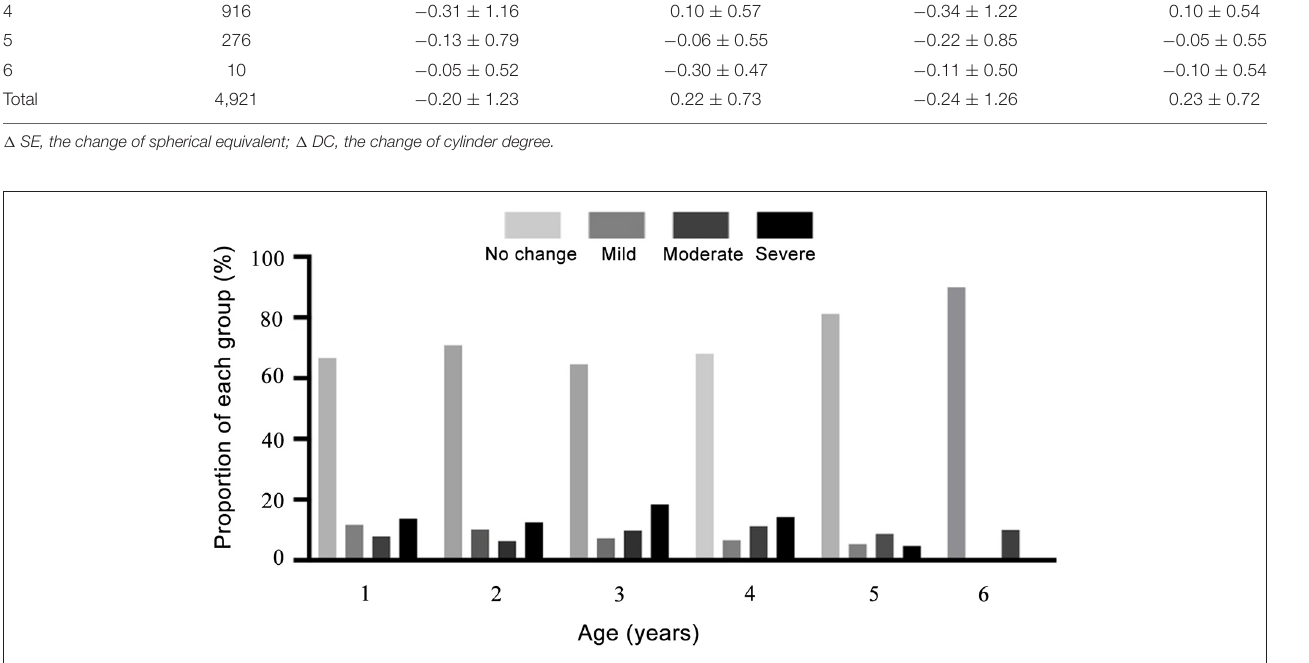
FIGURE 3 | The proportions of each group in myopia progression classification for preschool children aged 1–6 years.